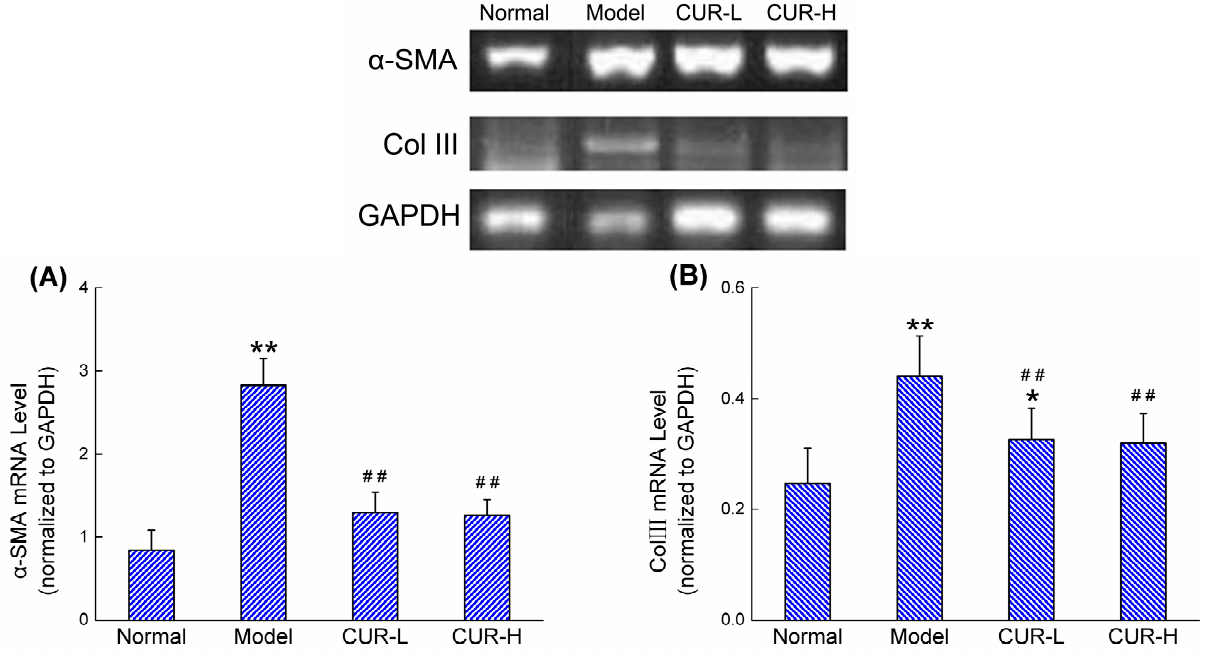
Figure 3. Effects of curcumin on mRNA expression of α -SMA and Col III in liver tissues. The sample tested in this experiment was abstracted from the liver tissues of rats: ( A ) α -SMA; ( B ) Col III. Data were expressed as mean ± SD. * p < 0.05, ** p < 0.01 compared with normal group, # p < 0.05, ## p < 0.01 compared with model group.